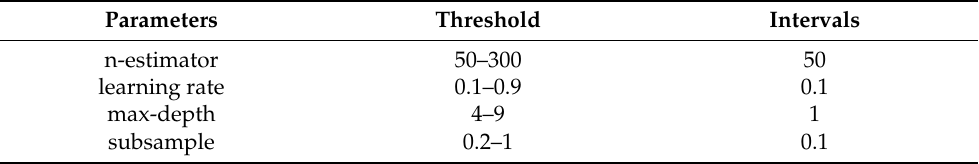
Table 1. Parameter settings to determine the optimal parameters for the GBRT